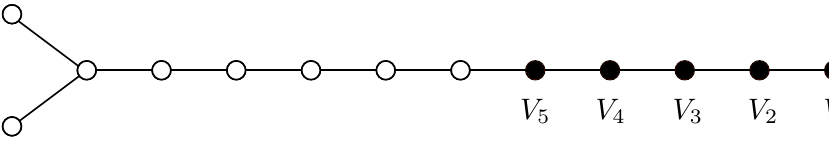
Figure 1 . Dynkin Diagram of the U -duality group SO(5 , 21) , which encodes the non-perturbative moduli space M , as per ref. [60]. The black dots denote five non-compact directions in which (5 , 21) one can take large distance limits. The directions V and V correspond to the standard limits of 1 2 weak 10d dilaton and large volume, respectively. Note that the basis of the V is not the same as i the basis of S which correspond to the weak coupling limits of 2-forms that we i